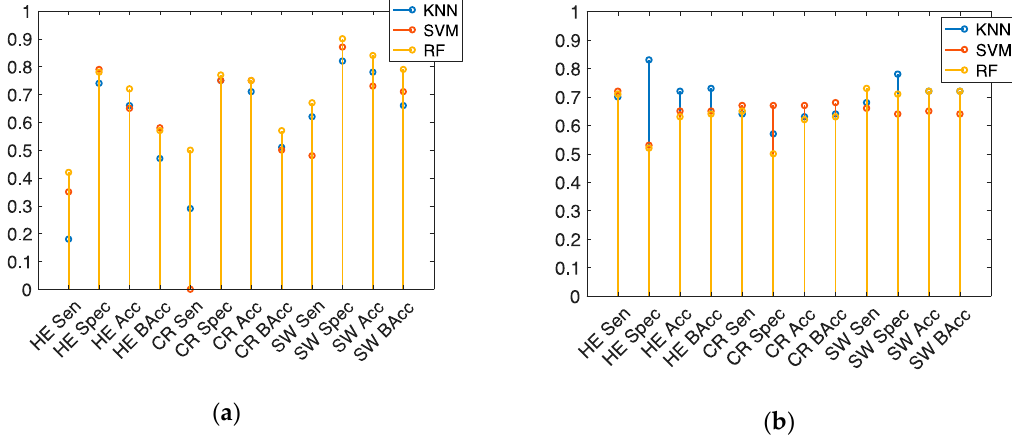
Figure 5. Scenario wise classification performance on the test dataset. ( a ) Shows results for BSet-1 ; and ( b ) Shows results for BSet-2 .